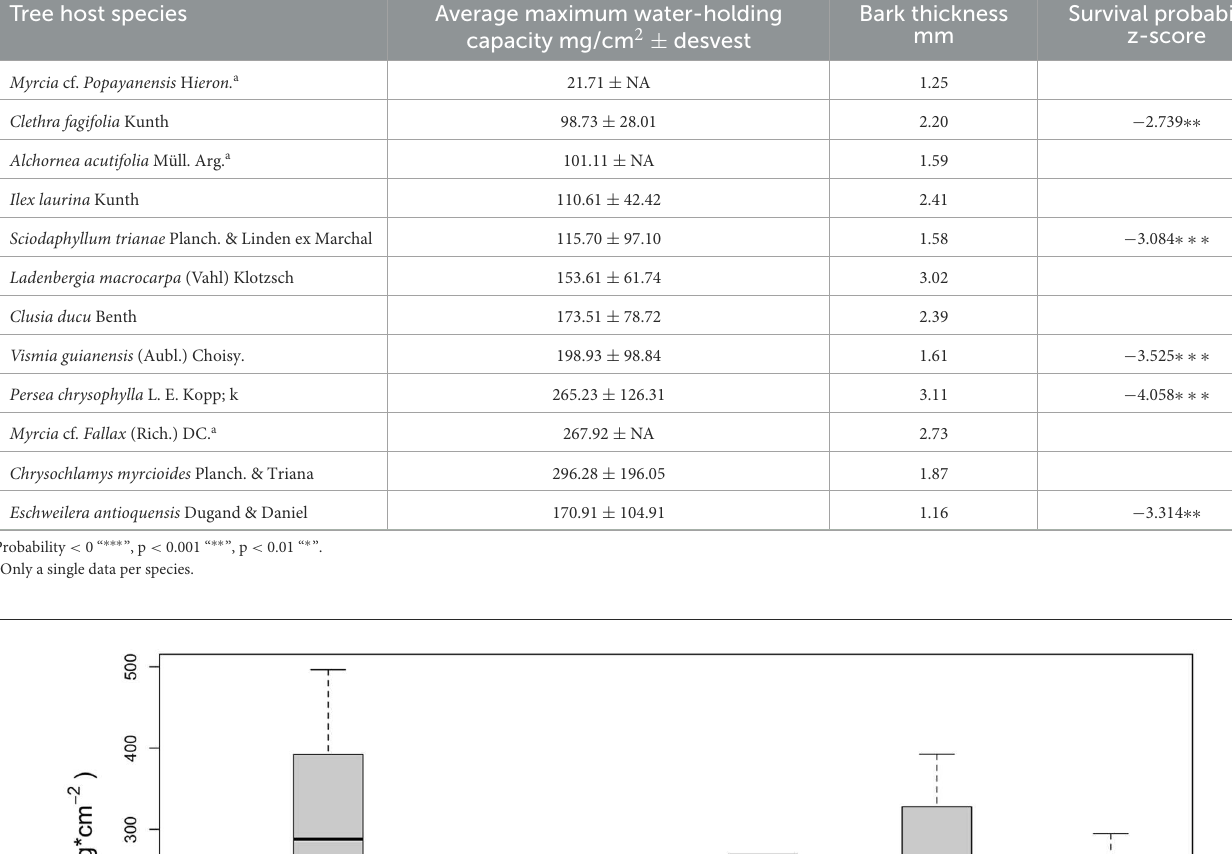
TABLE 2 Descriptors of host tree species and the survival probability z-score ∗ . Tree host species Average maximum water-holding